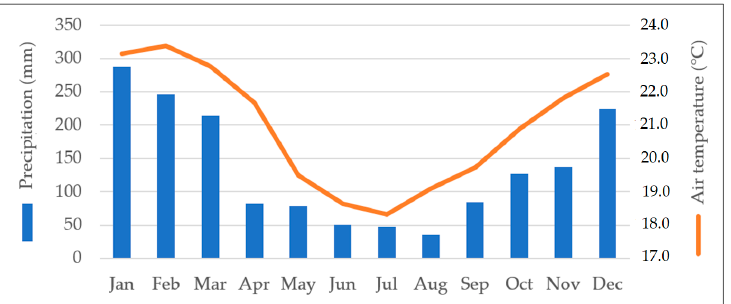
Figure 2. Climograph of the monthly variation in average air temperature and accumulated precipitation for the city of São Paulo, Brazil, in between 1981 and 2010, according to the data calculated by the National Institute of Meteorology (INMET) of Brazil according to the World Meteorological Organization (WMO) requirements, available in Table 2. Source: National Institute of Meteorology (INMET) of Brazil, normal climatological of 1981–2010. Figure elaborated by authors (2021). Table 2. Climatological data of São Paulo from Mirante de Santana weather station, calculated by the National Institute of Meteorology (INMET) of Brazil according to the World Meteorological Or- ganization (WMO) requirements. Source: National Institute of Meteorology (INMET) of Brazil, nor- mal climatological of 1981–2010 and records of temperature from 1945 to present. Table elaborated by authors (2021).